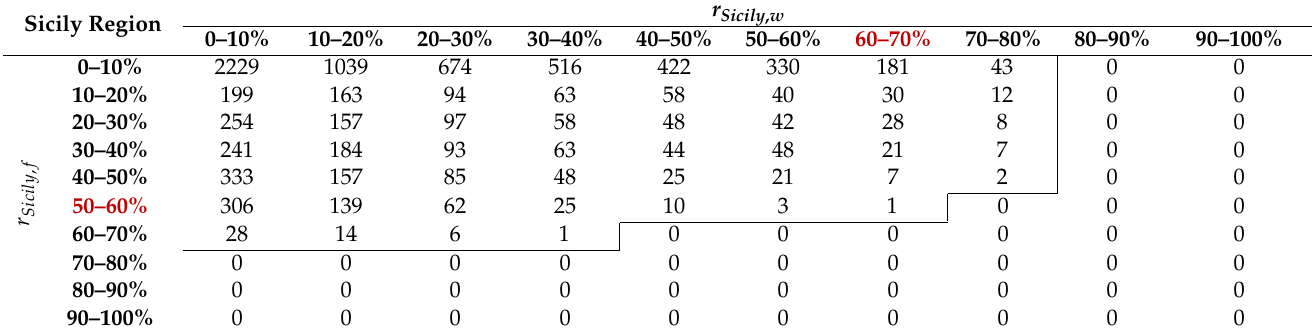
Table 4. Correlation matrix between solar and wind technologies’ producibilities for Sicily region.